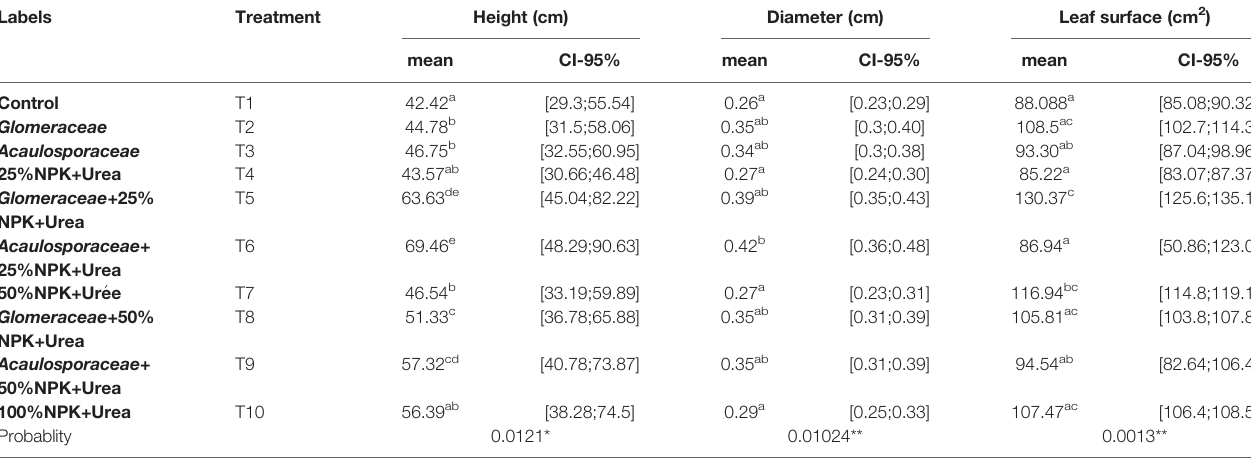
TABLE 2 | Effect of mycorrhizal fungi on growth variables in the greenhouse at 30 days after sowing.